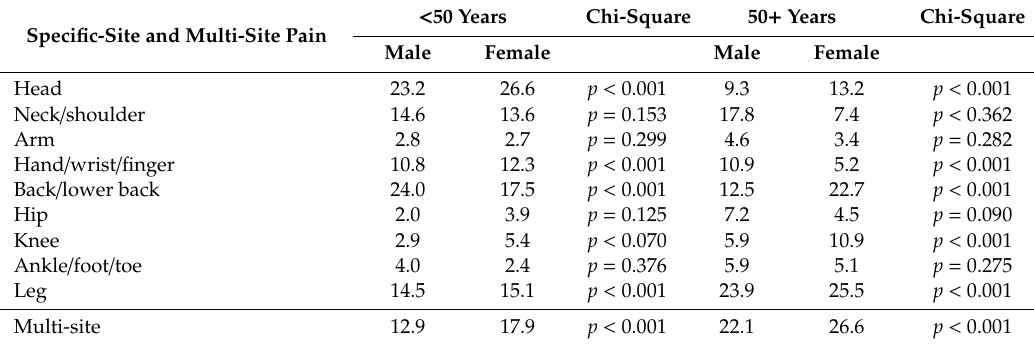
Table 2. Pain sites among those reported pain, IFLS